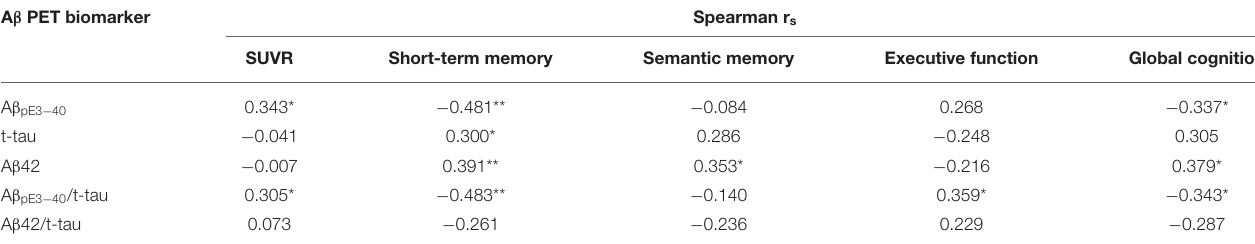
TABLE 2 | Correlation of plasma biomarkers with A β burden and cognitive performance ( N = 46). A β PET biomarker